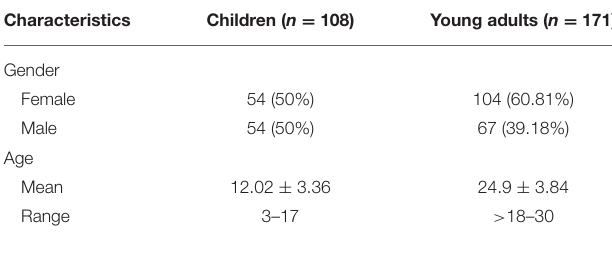
TABLE 1 | Baseline characteristics of RHD